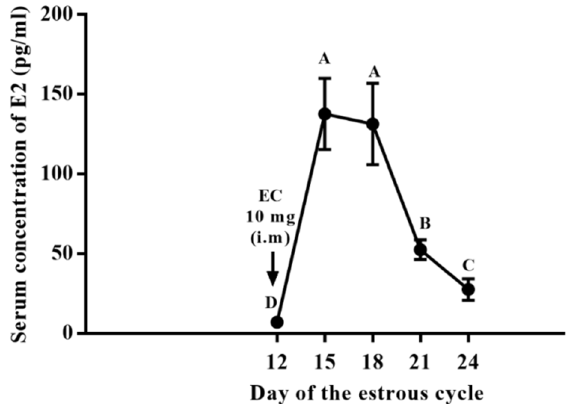
Figure 2. Serum concentration of E2 after estradiol cypionate administration. Capital letters indicates statistical difference ( p < 0.05).